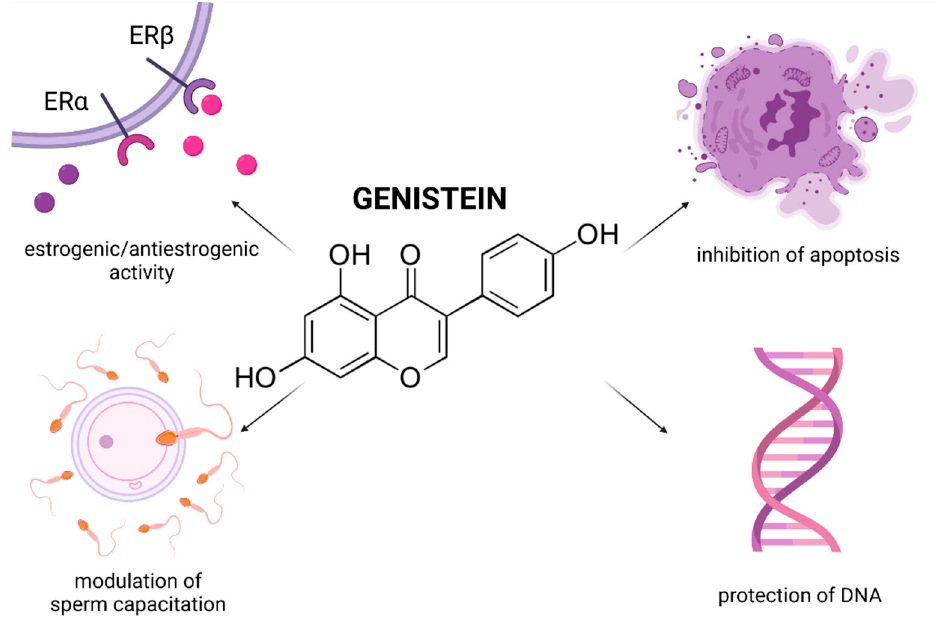
Figure 7. Most frequently reported beneficial effects of genistein on spermatogenesis, sperm structural integrity and functional activity.